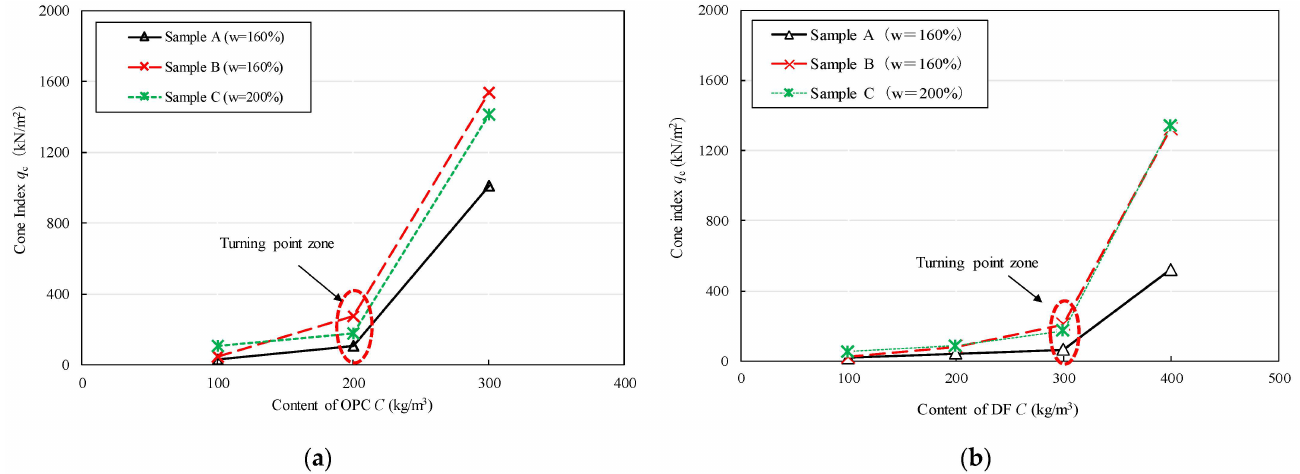
Figure 6. Relationship between cone index of stabilized clay and content of solidifying agents. ( a ) Stabilized clay by OPC, ( b ) Stabilized clay by